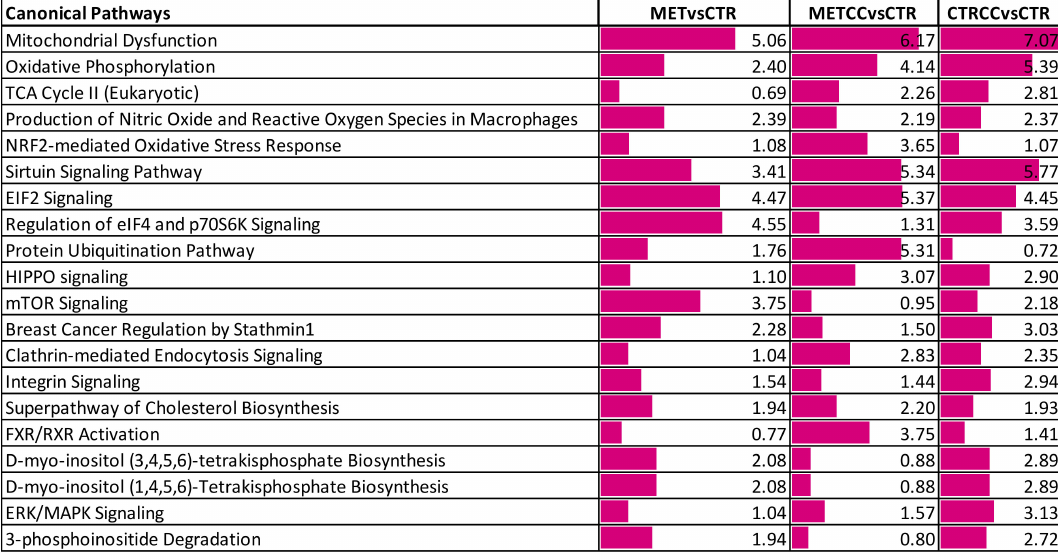
Figure 3. Bioinformatic analysis of the proteomic data on HepG2 cells grown for 48 h (CTR), in the presence of Compound C (CTRCC), high methionine (MET) and high methionine and Compound C (METCC). The analysis was carried out by IPA on the proteins di ff erentially expressed among the comparison MET versus CTR, METCC versus CTR and CTRCC versus CTR. Proteins were considered di ff erentially expressed if they were present only in one condition or showed significant t -test di ff erence (Student’s t -test p -value 0.05). Functional grouping was based on Fischer’s exact test p value ≤ 0.05 and at least three counts. The colored bars are a visual representation of the corresponding –log p -value reported